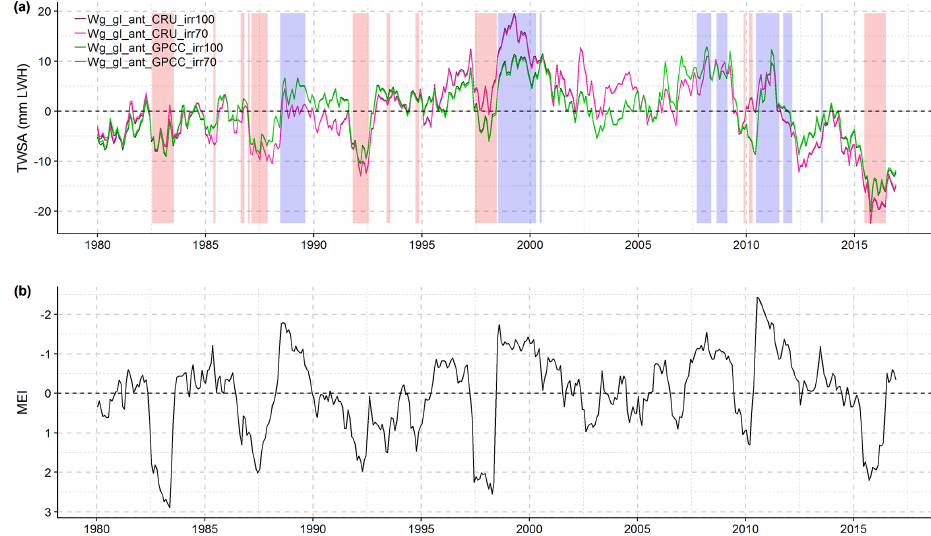
Figure 8. Relation between global monthly TWSA and ENSO from January 1980 to December 2016. (a) Residual TWSA (non-linear interannual variability) computed with four variants of integrated WaterGAP (Wg_gl) in anthropogenic mode (Table 1). Anomalies are relative to the mean over January 1990 to December 2010 and given in millimetres of land water height (mmLWH). (b) Intensities in Multivariate ENSO Index (MEI) version 2 (produced by NOAA). Positive MEI values indicate El Niño and negative values indicate La Niña phases. El Niño (red) and La Niña (blue) phases are highlighted in the plot (a) whenever the MEI is larger than 1 or smaller than − 1, respectively. Note the reversed vertical axis in (b)